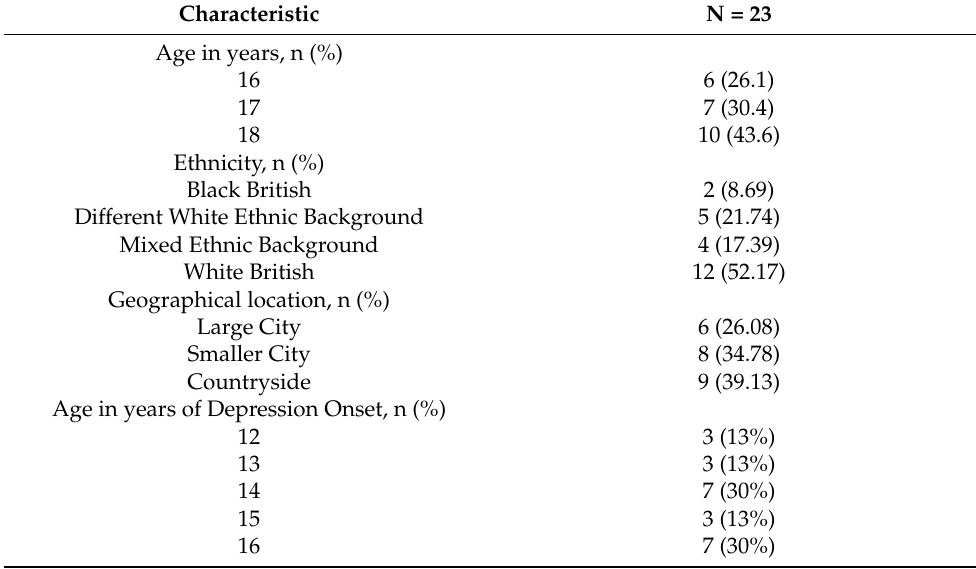
Table 1. Participant Demographic Data.